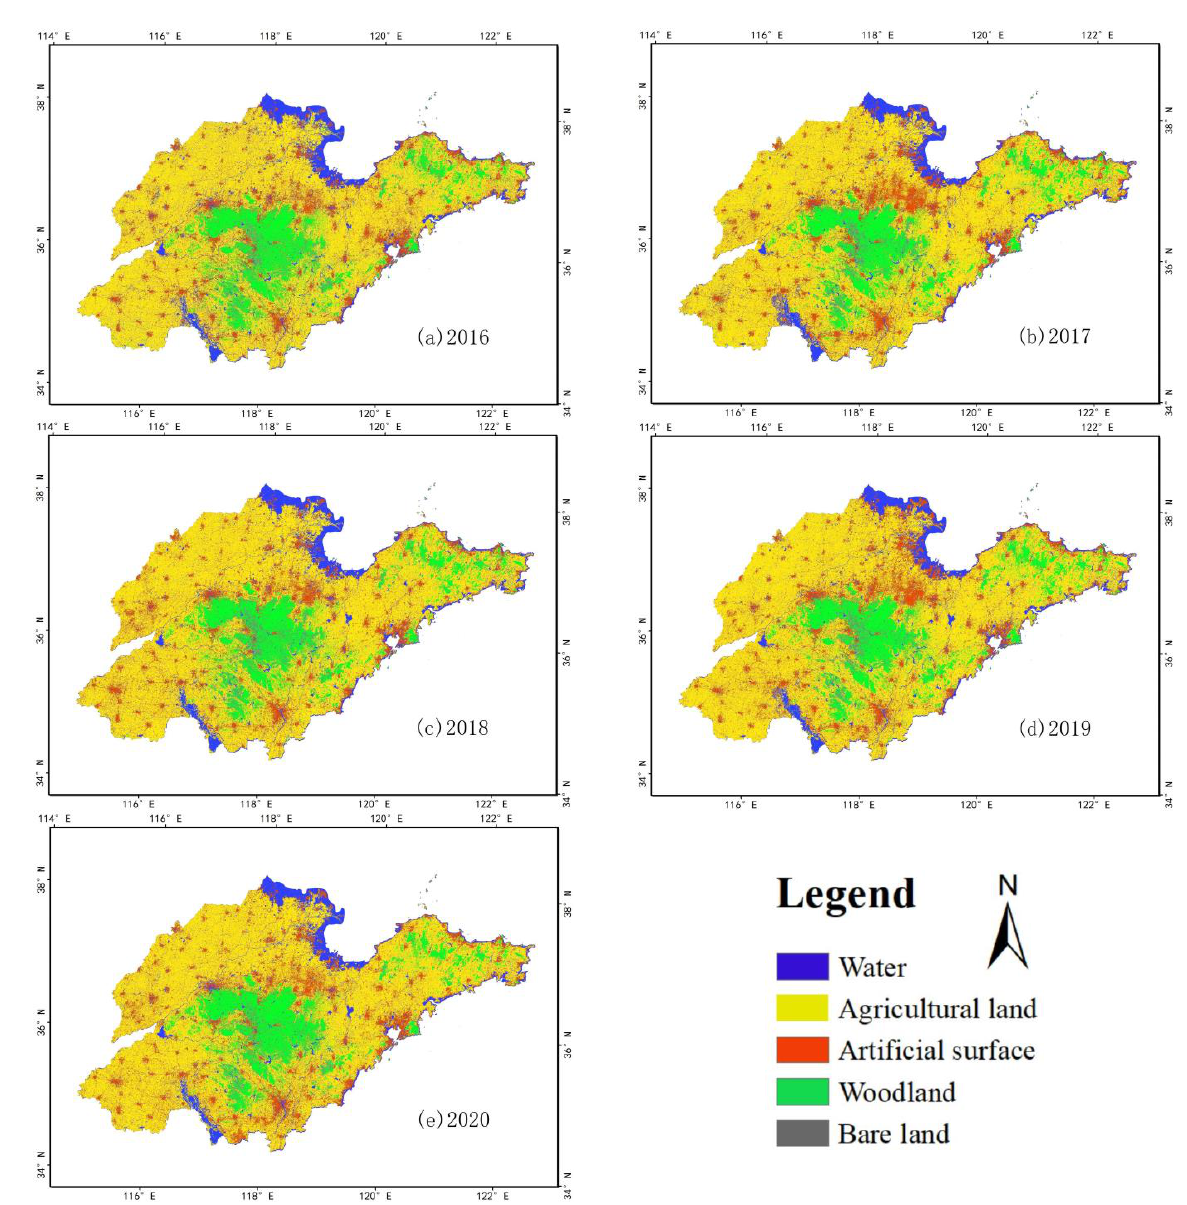
Figure 9. Agricultural land classification map of Shandong Province in the last five years. ( a ) Land use classification map of Shandong Province in 2016; ( b ) Land use classification map of Shandong Province in 2017; ( c ) Land use classification map of Shandong Province in 2018; ( d ) Land use classification map of Shandong Province in 2019; ( e ) Land use classification map of Shandong Province in 2020.